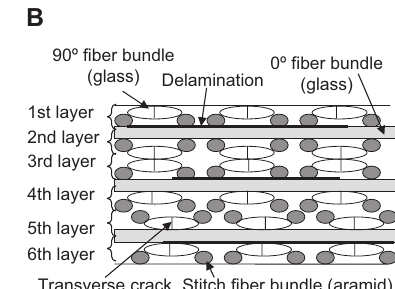
AR-AR-AR specimen. The highest numbers of transverse cracks and long delaminations were observed on the GF- GF-AR specimens during the plate bending impact test. The length of delamination with the GF-GF-AR speci- men was 5.9 mm, and with the AR-AR-AR specimen, 5 mm.